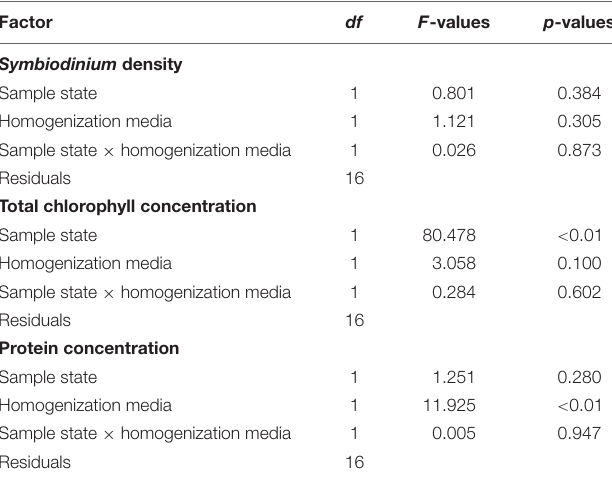
TABLE 2 | Statistical results about the effect of sample state, and homogenization media on Symbiodinium density, total chlorophyll, and protein concentrations measured in Heteroxenia fuscescens .